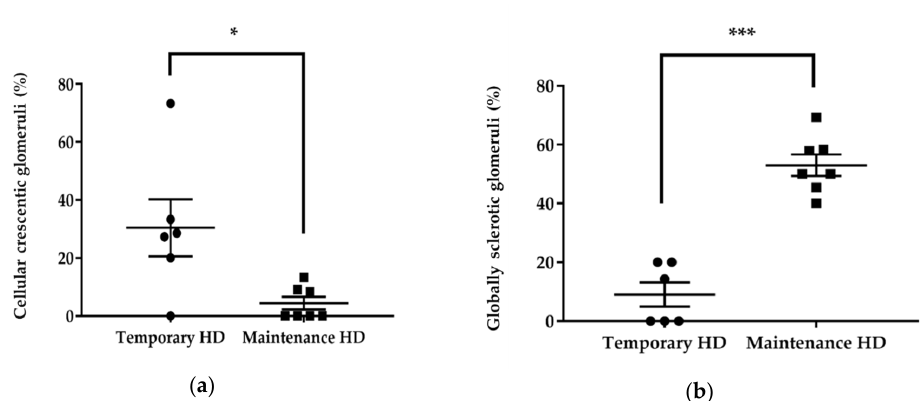
Figure 6. Quantification of histological findings in the temporary and maintenance hemodialysis (HD) groups. ( a ) Comparison of the percentage of glomeruli with cellular crescent between the temporary and maintenance HD groups. ( b ) Comparison of the percentage of globally sclerotic glomeruli between the temporary and maintenance HD groups. Bars indicate mean ± SEM. *, p < 0.05; *** p < 0.001. HD — hemodialysis.